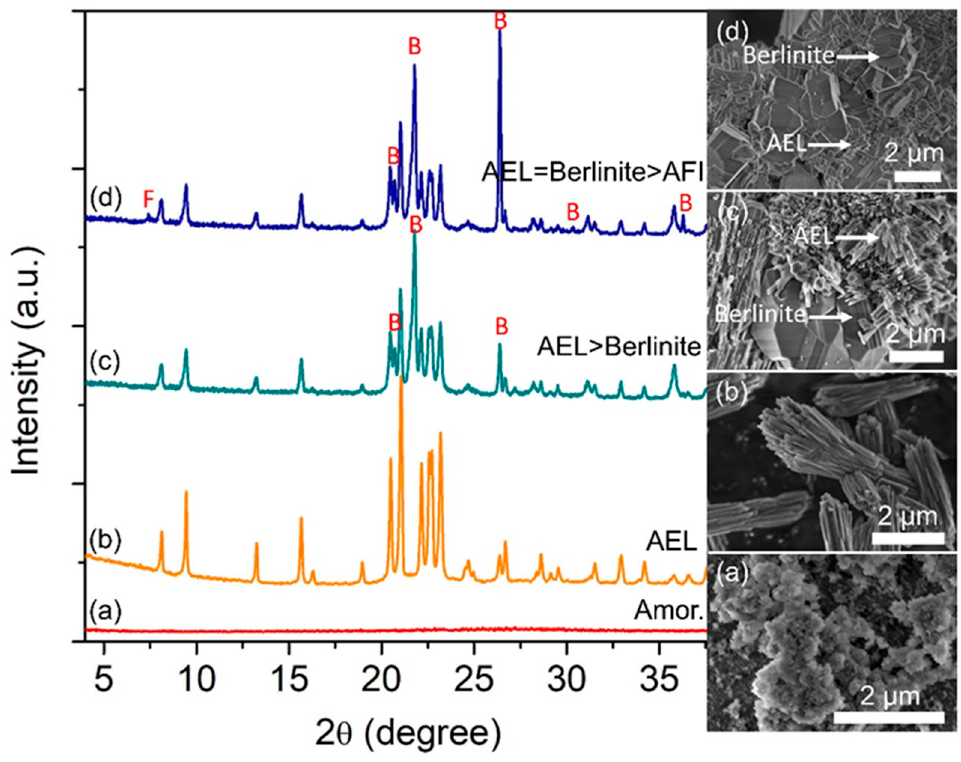
Figure 3. XRD patterns and FESEM images of ( a ) E-8 ( x = 1.2), ( b ) E-3 ( x = 1.8), ( c ) E-9 ( x = 2.1) and ( d ) E-10 ( x = 2.4) samples. The samples were prepared using the ionogel of 1.0Al: x P: 0.3Si: 38[PPy]Br heated at 150 °C for 133 h. F and B denote the presence of AFI and berlinite crystalline phases, re- spectively.